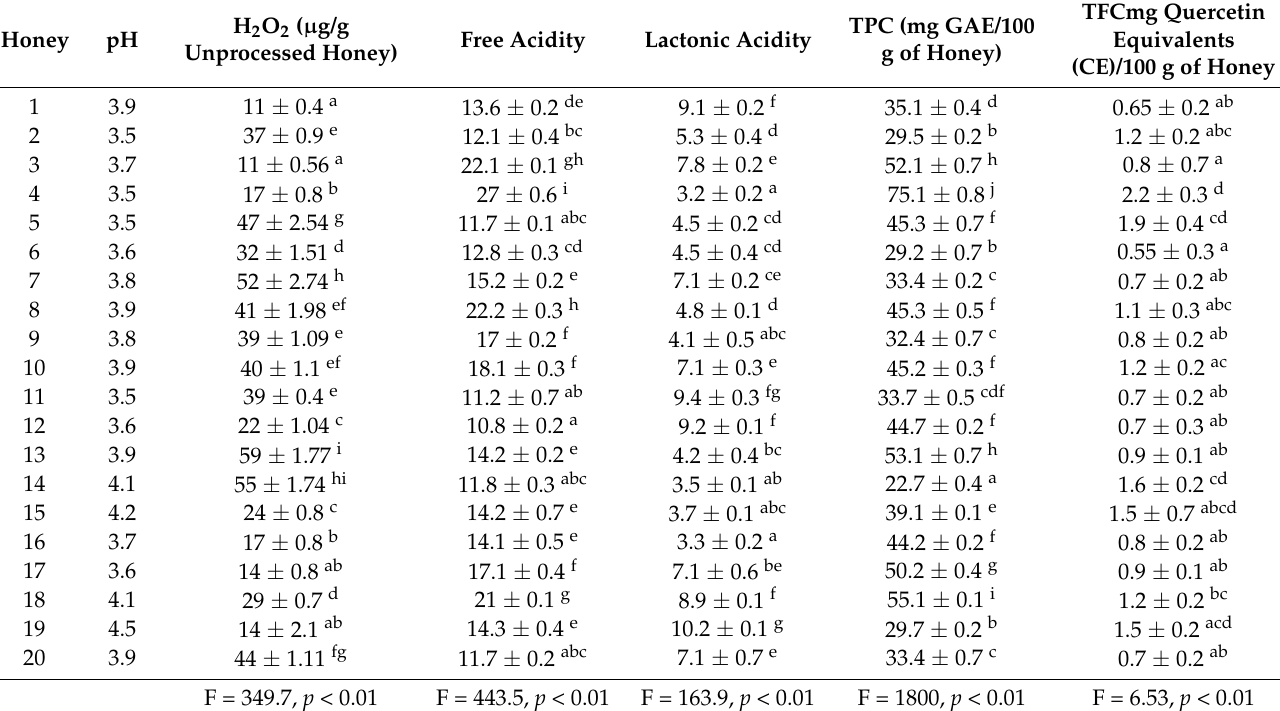
Table 2. Physicochemical characteristics of the 20 citrus honey samples.